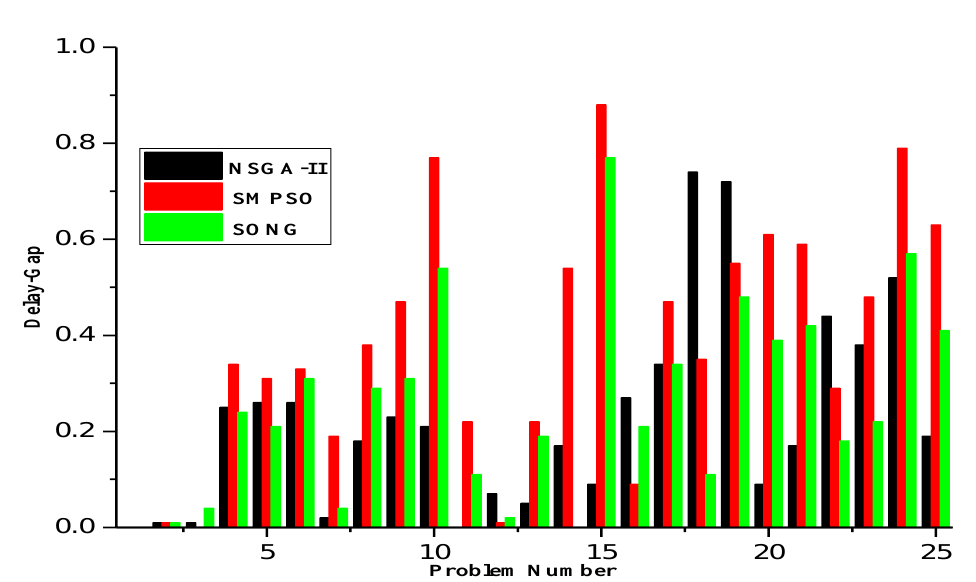
Figure 16. Delay Gap Comparison with reference to